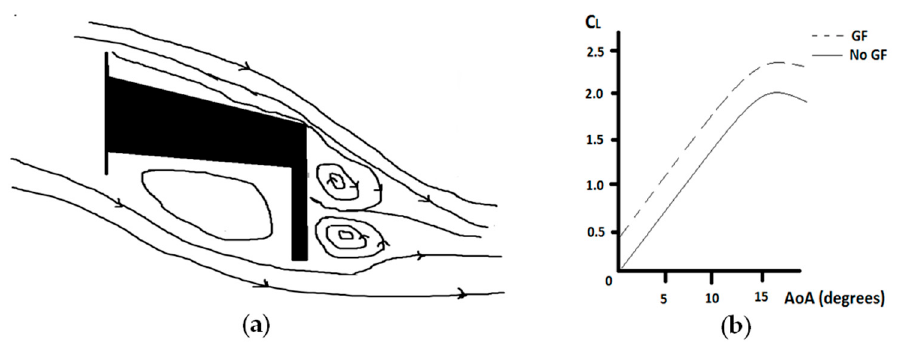
Figure 1. ( a ) GF placed in the suction side of a WT airfoil; ( b ) Lift coefficient improvement with GF.